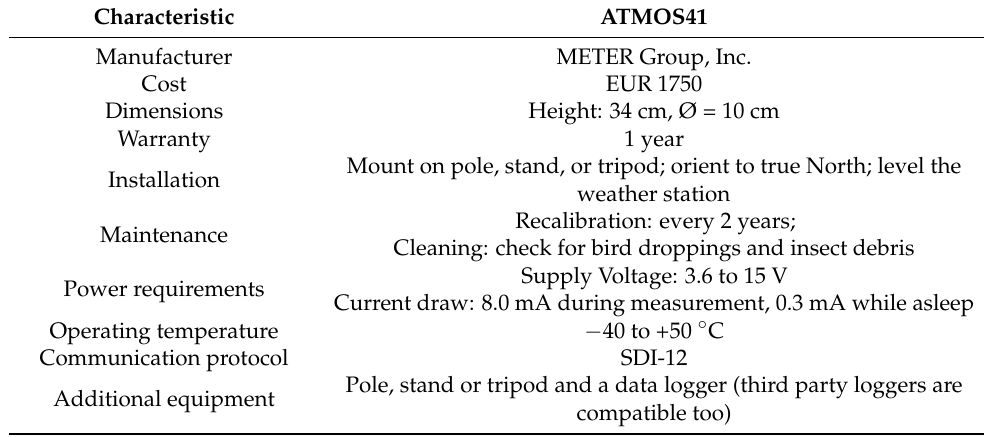
Table 1. Characteristics of the ATMOS41 all-in-one weather station. Characteristic ATMOS41 Manufacturer METER Group,